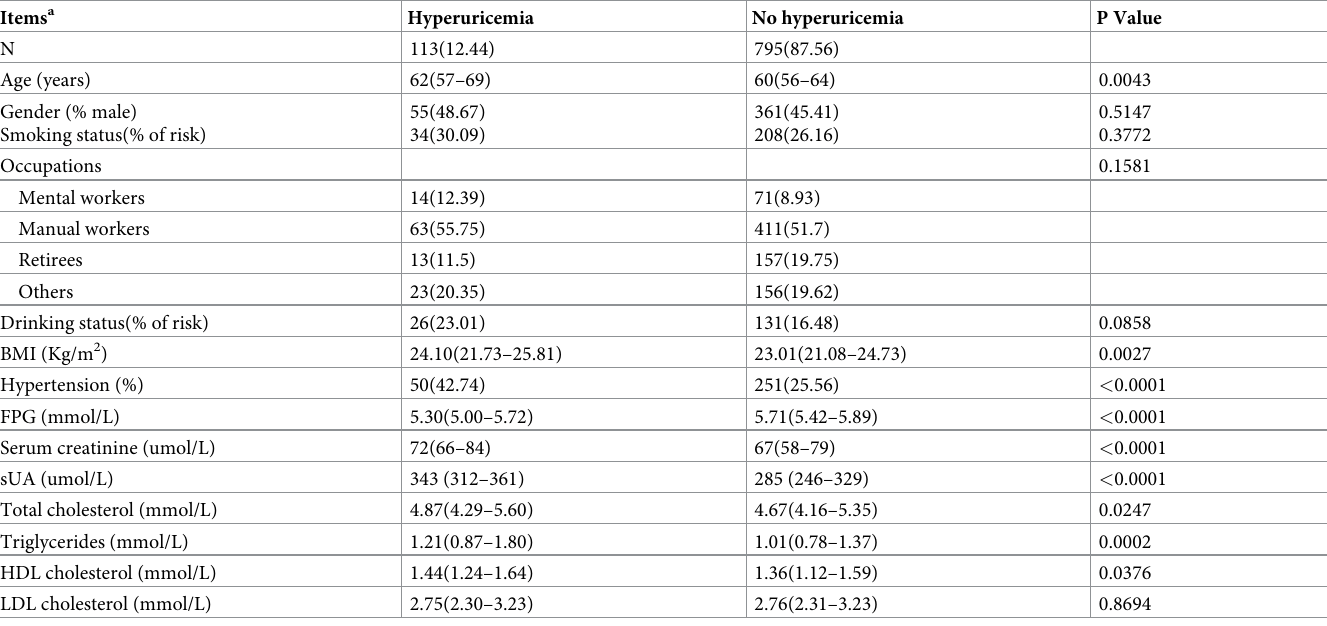
Table 4. Characteristics of PSI participants with or without